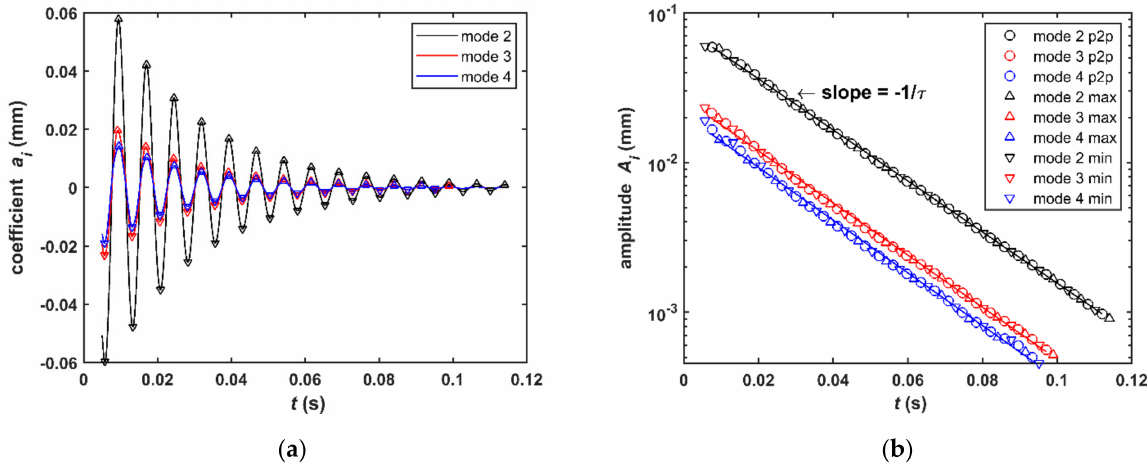
Figure 4. The evaluation of bubble shape oscillations for 0.1 × 10 − 3 mol/L n -Octanol solution, bubble size D b = 1.173 mm, time t = 0 s corresponds to the end of the needle movement; ( a ) time dependence of Legendre polynomial coefficient a i for mode 2, 3 and 4; ( b ) time dependence of amplitudes A i for modes 2, 3 and